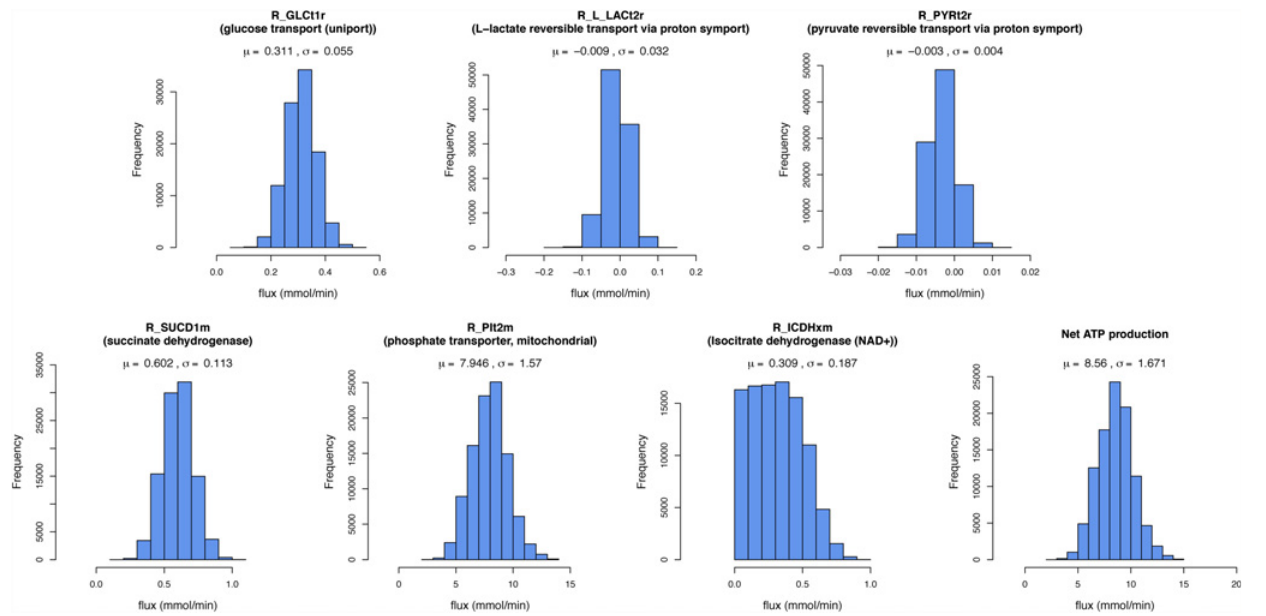
Fig 3. Ensemble analysis of uncertainty of flux estimations for brain